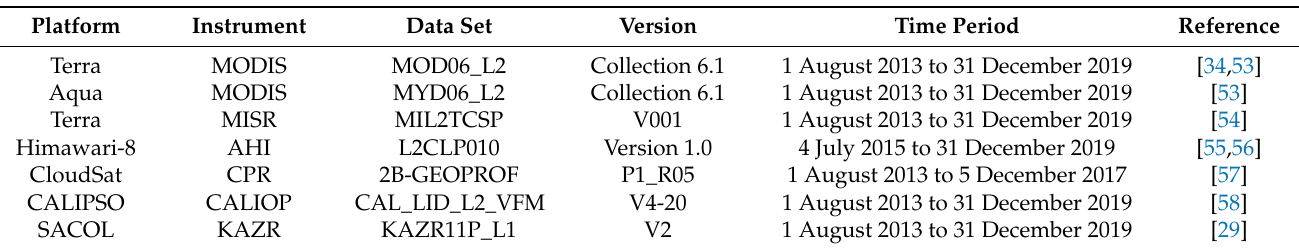
Table 1. Product information in